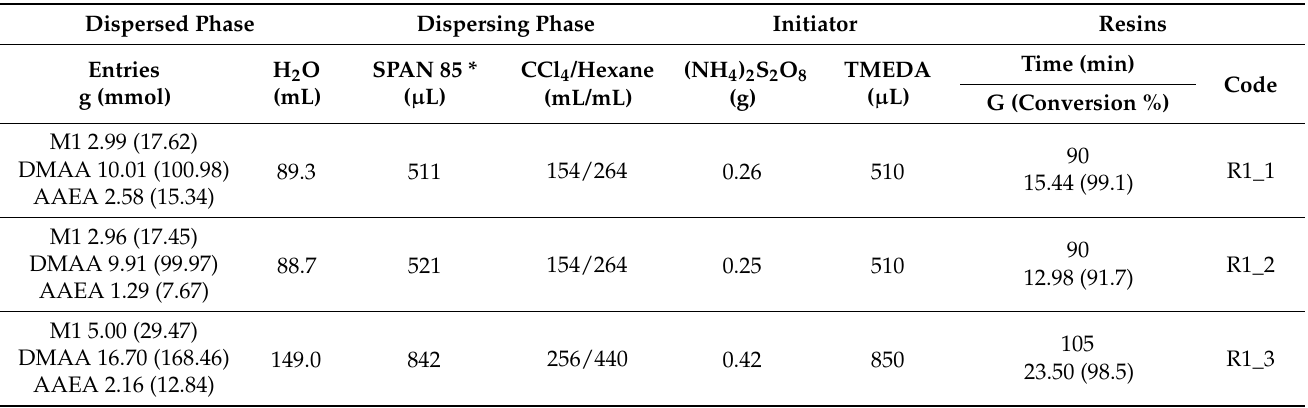
Table 8. Experimental data of three representative polymerizations for preparing R1. The stoichiome- try and conditions described are those optimized over several